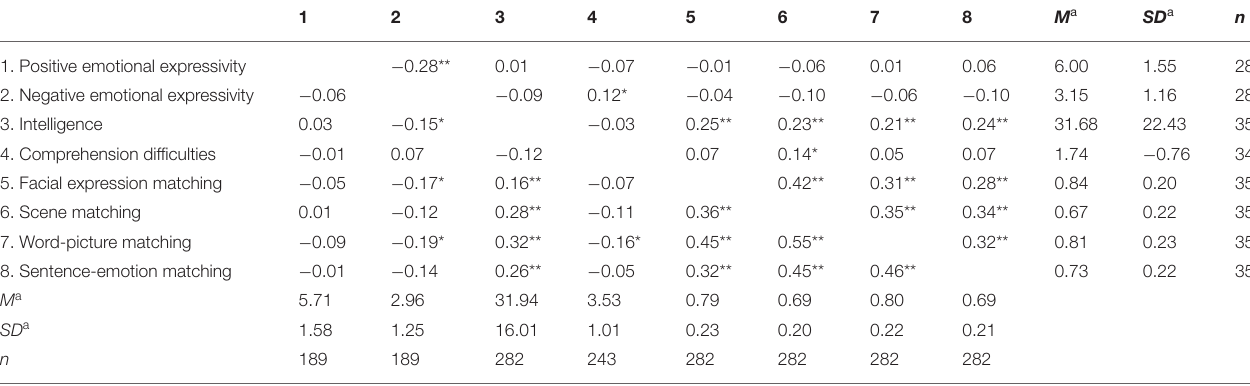
TABLE 2 | Correlations, means ( M ), and standard deviations ( SDs ) among